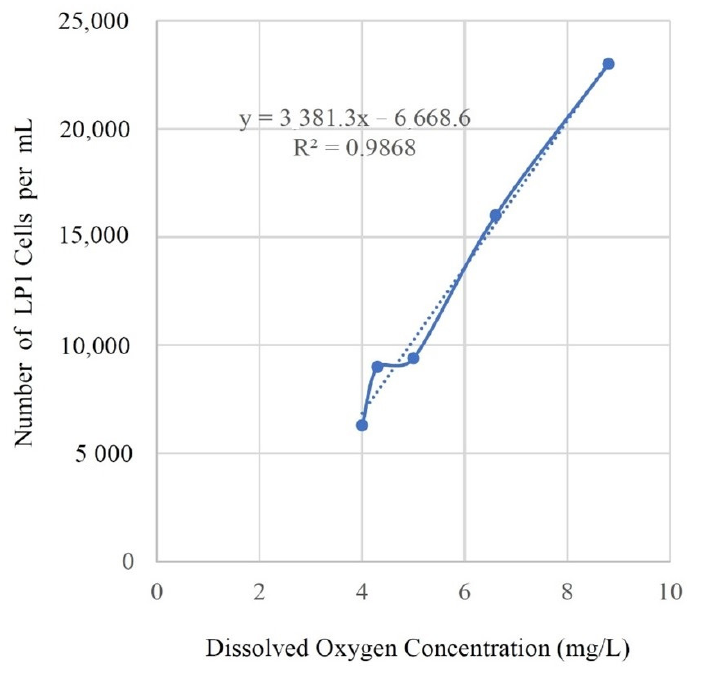
Figure 2. LP1 vs. Dissolved Oxygen in Cooling Tower Water.